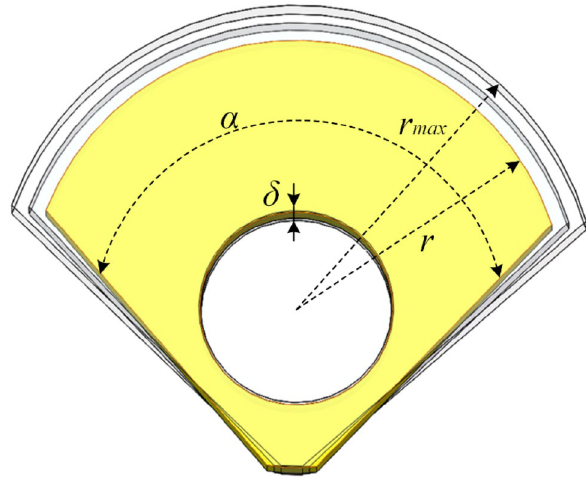
Fig. 11 Structure of eccentric mass